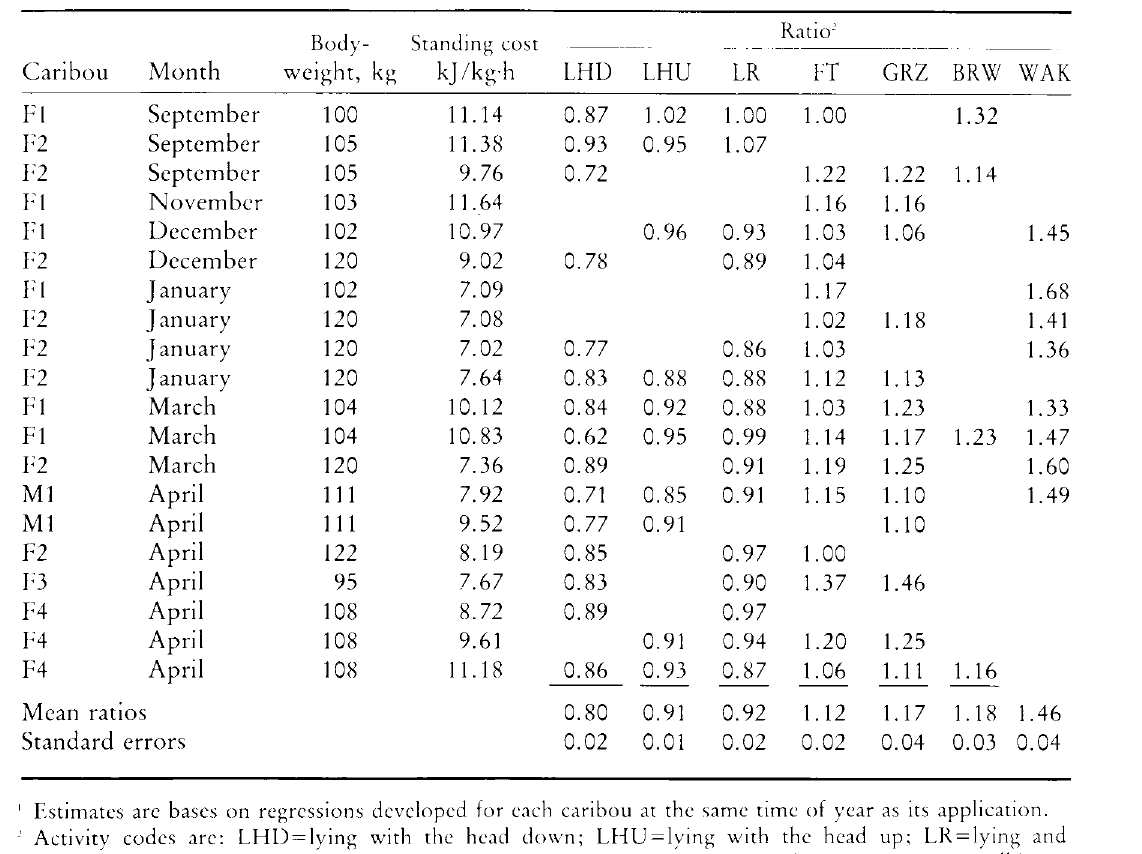
Tabic 2. Energy costs of activities relative to the cost of standing, as estimated from heart rates of caribou 1 . Body- Standing cost _. . _ Caribou